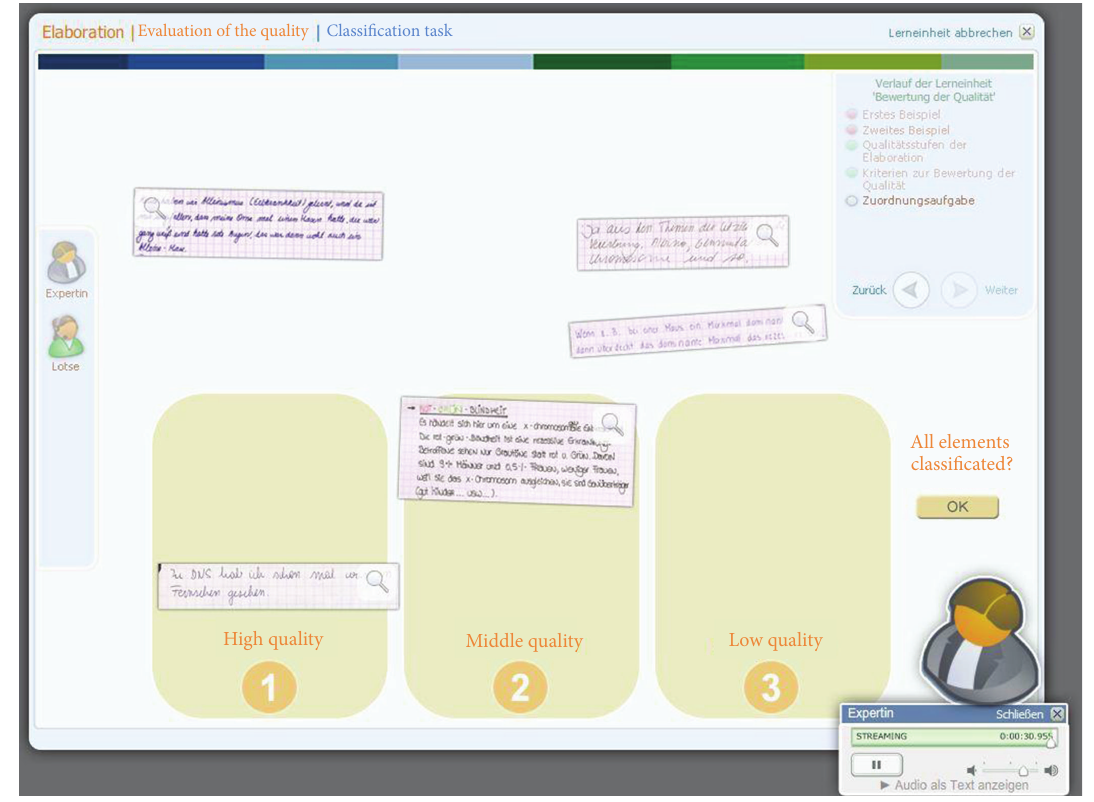
Figure 6: Classification tasks. In order to train to differentiate different levels of quality (high, middle, and low), teachers had to classify journal passages by dragging and dropping them to the three boxes (1), (2), and